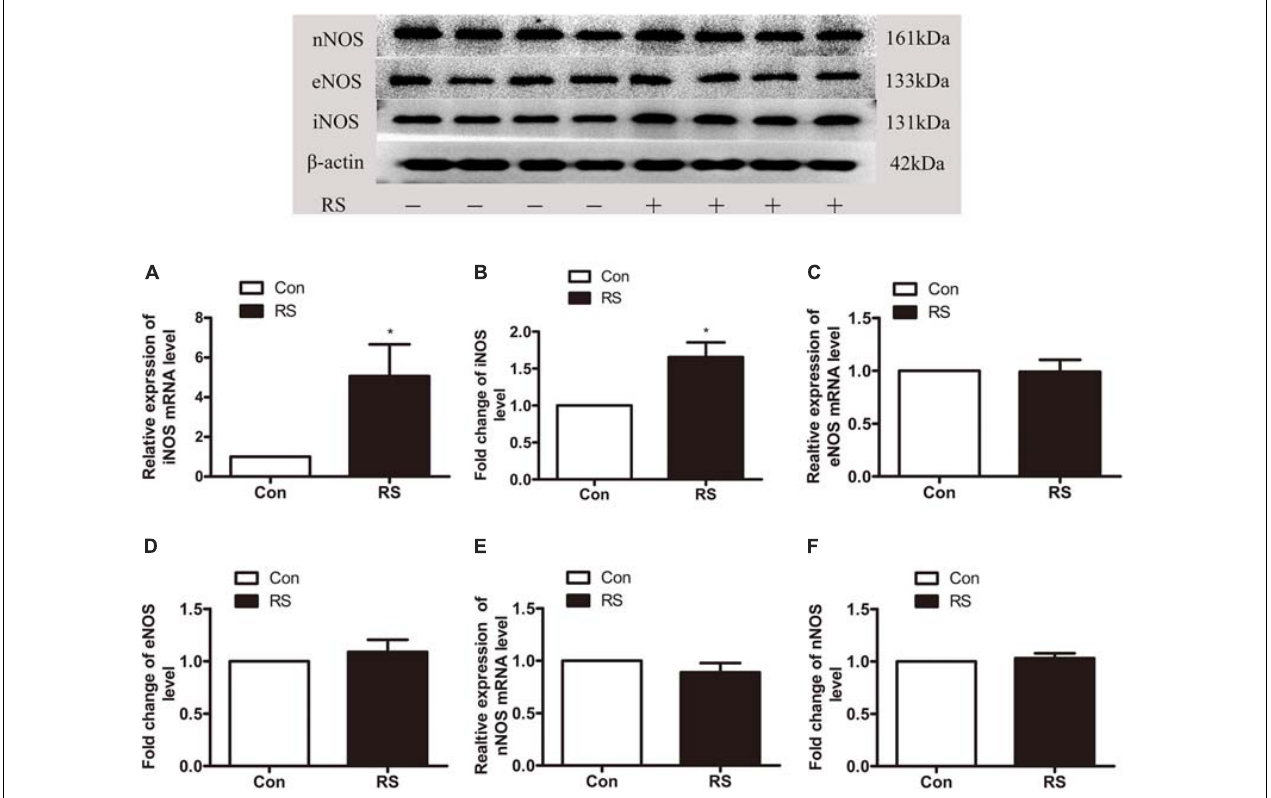
FIGURE 5 | The expression of three isoforms of NOS in the spinal cord in the chronic RS or control rats. (A,B) The expression of spinal iNOS mRNA ( P = 0.045) and protein ( P = 0.046) in the rats subjected or not subjected to chronic RS. (C,D) The expression of spinal eNOS mRNA ( P = 0.937) and protein ( P = 0.449) in the rats subjected or not subjected to chronic RS. (E,F) The expression of spinal nNOS mRNA ( P = 0.3) and protein ( P = 0.565) in the RS rats or control rats. Data are presented as mean ± SEM ( n = 4), * P < 0.05. NOS, nitric oxide synthase; RS, restraint stress; iNOS, inducible nitric oxide synthase; eNOS, endothelial nitric oxide synthase; nNOS, neuronal nitric oxide